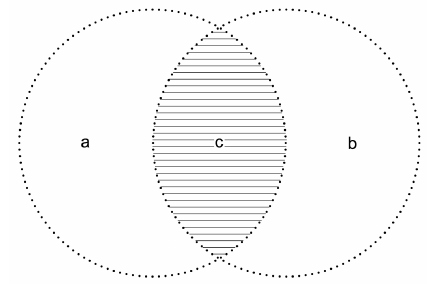
Figure 1. The model of res mixtae .